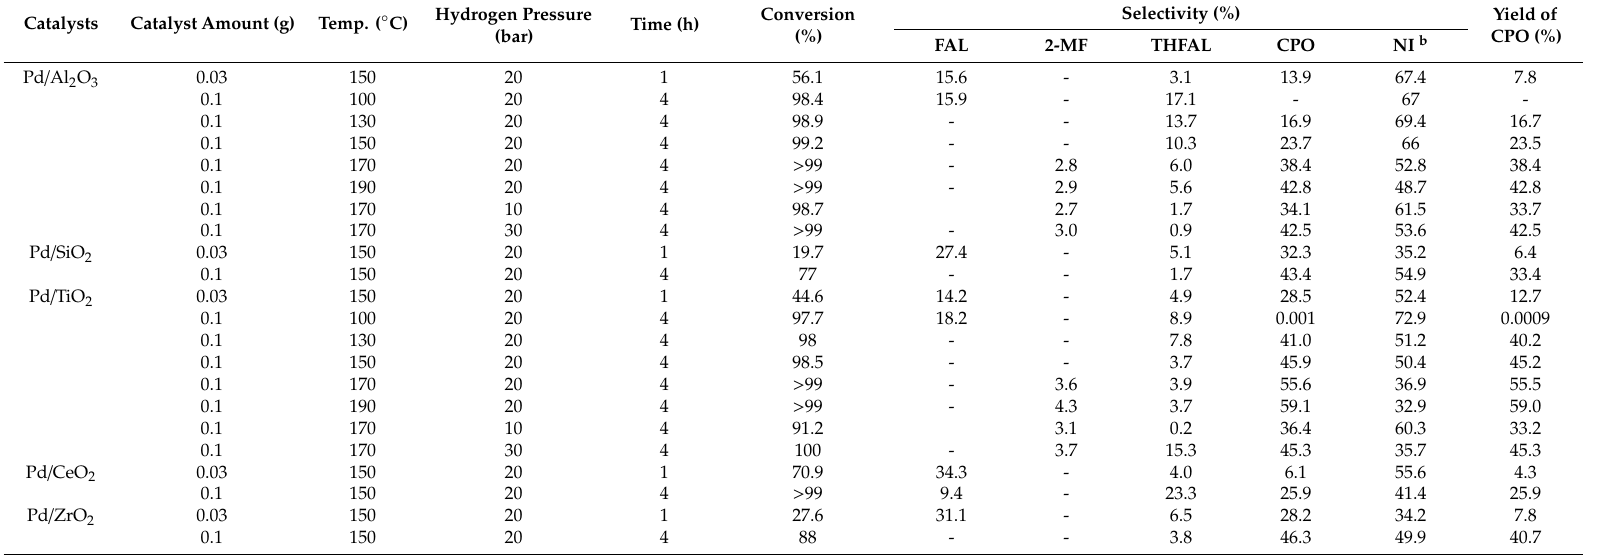
Table 3. Hydrogenation of furfural over Pd catalysts a